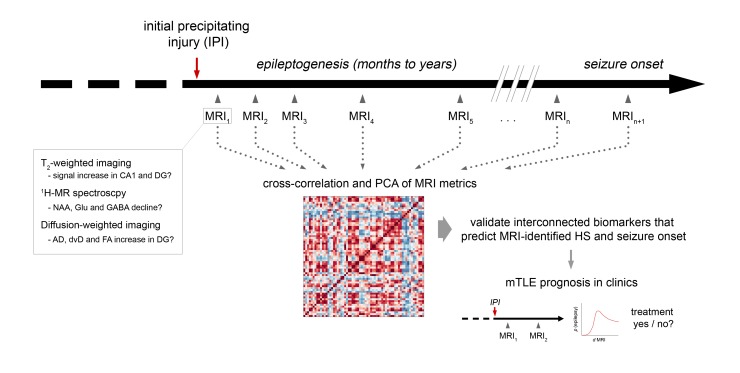
Experimental design to translate MRI biomarkers into the clinic.Schematic illustrating an outline for the clinical translation of experimentally-identified biomarkers. Multimodal MRI is repeatedly applied early after the initial precipitating injury (IPI) until the onset of clinical seizures. Cross-correlation and PCA identifies interconnected MRI parameters and validates their predictive value with respect to MRI-identified HS and seizure onset in chronic mTLE. Subsequently, the change of MRI metrics (d) early after IPI can be assigned to the probability (p) of epilepsy onset and severity. Most robust MRI biomarkers can then be routinely used in clinics to prognose acquired mTLE, which allows to start anti-epileptogenic treatment early before clinical manifestation of epilepsy.